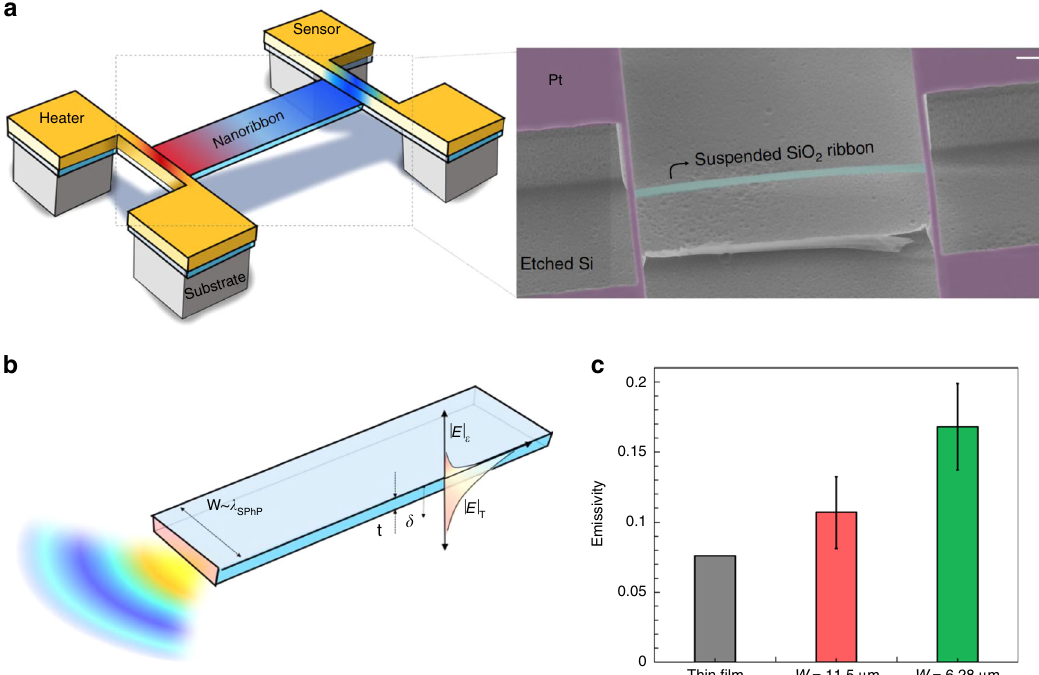
Fig. 1 Measuring the thermal emissivity of SiO 2 nanoribbons. a Schematic illustration and scanning electron microscope (SEM) image of the suspended thermal transport measurement micro-device with a SiO 2 nanoribbon where one can see the suspended heater and sensor electrodes (Pt) and a nanoribbon across the electrodes 8 . The scale bar in the SEM image represents 30 μ m. b Schematic illustration of a long SiO 2 nanoribbon with rectangular cross-section with thickness t and width W . Here, t is smaller than the skin depth δ and the thermal wavelength λ Th , while W is comparable to the wavelength of the surface phonon polaritons λ SPhP . c Measured emissivity at room temperature for 100 nm-thick ribbons with thickness of 6.28 and 11.5 μ m. This emissivity is compared to the computed result for an in fi nitely wide thin fi lm of the same thickness. Reprinted from ref. 8 with permission from Springer